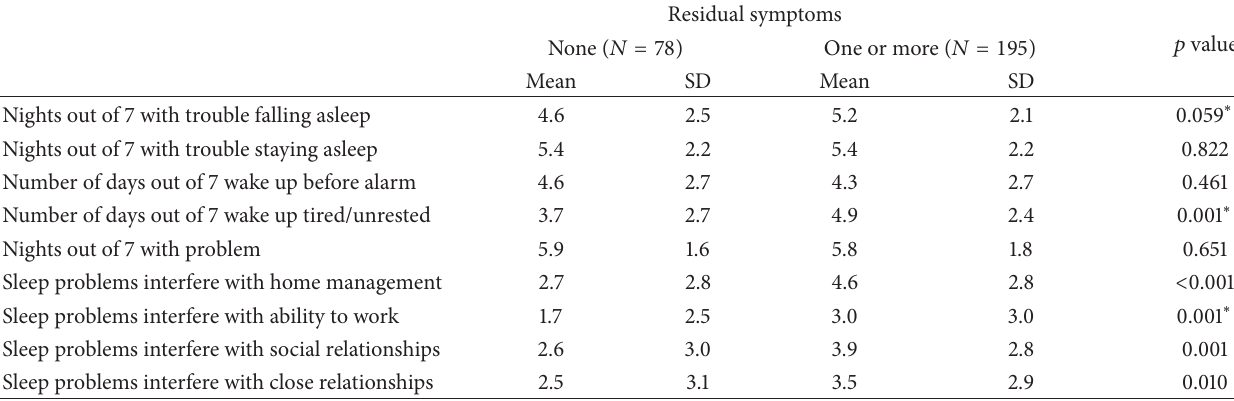
Table 5: Sleep-related trouble according to the presence of residual symptoms in respondents 65 years and older. Residual